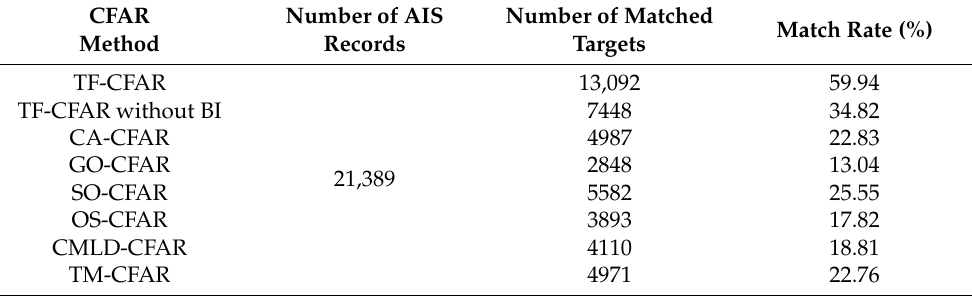
Table 3. Match rates by different CFAR methods on 25 September 2015.